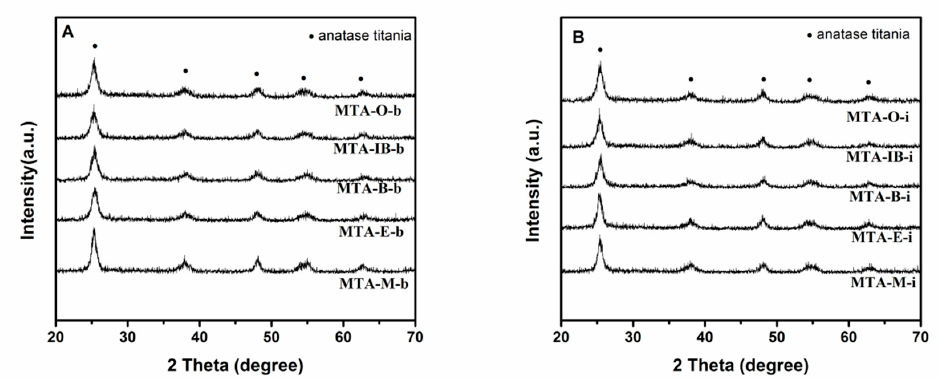
Figure 5. XRD patterns of samples MTA-b ( A ) and MTA-i ( B ) after calcination at 750 °C.